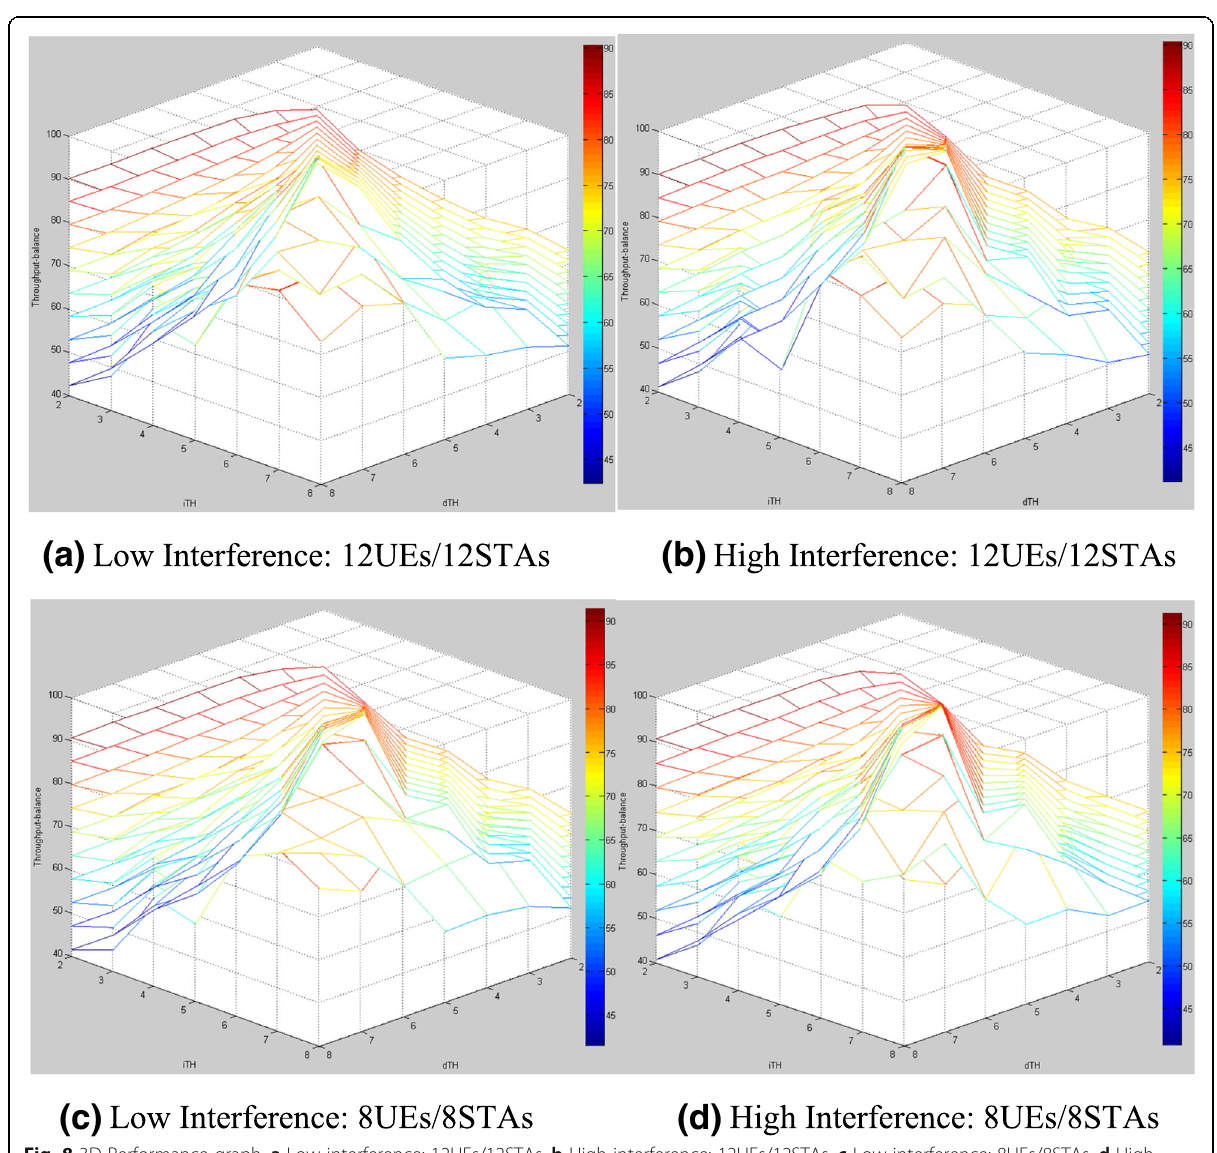
Fig. 8 3D Performance graph. a Low interference: 12UEs/12STAs. b High interference: 12UEs/12STAs. c Low interference: 8UEs/8STAs. d High interference: